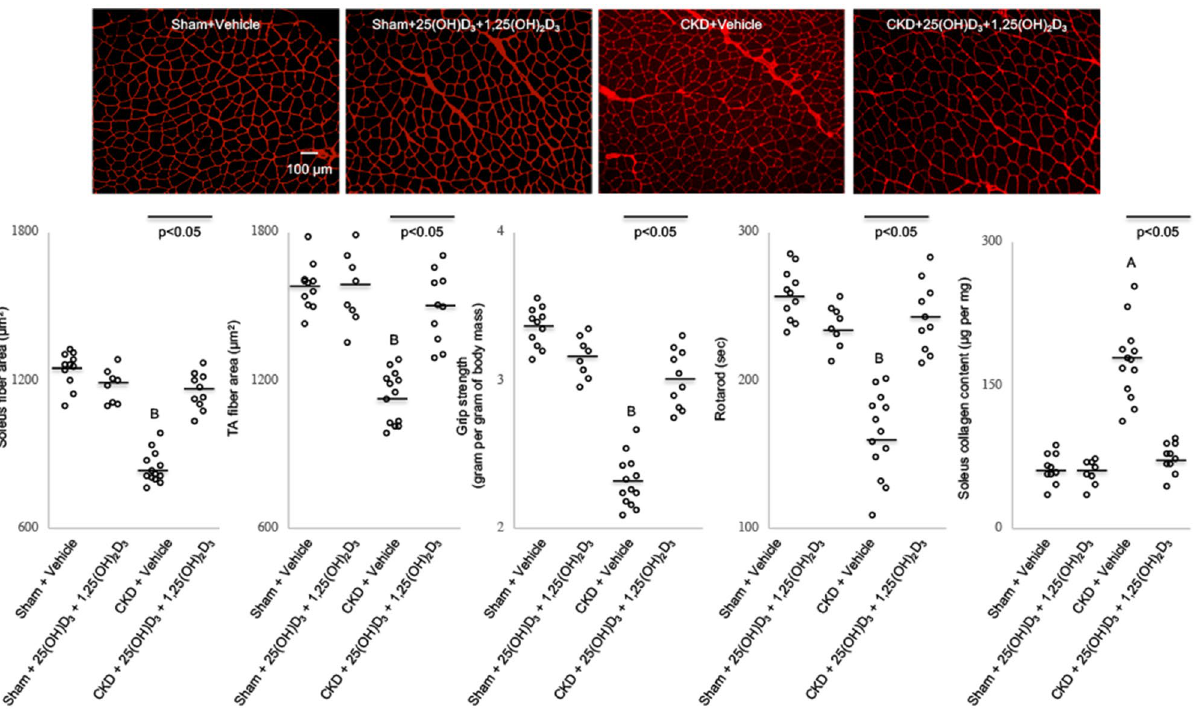
Figure 4. Vitamin D repletion improves muscle fiber size and in vivo muscle function as well as normalizes muscle collagen content in CKD mice. Representative photomicrographs of soleus immunohistochemical sections labeled with a polyclonal antibody to laminin with magnification ×200 . Average soleus and tibialis anterior cross-sectional area as well as in vivo grip strength and rotarod activity were measured. Muscle collagen content was quantitated. Results are analyzed and expressed as in Fig. 1.